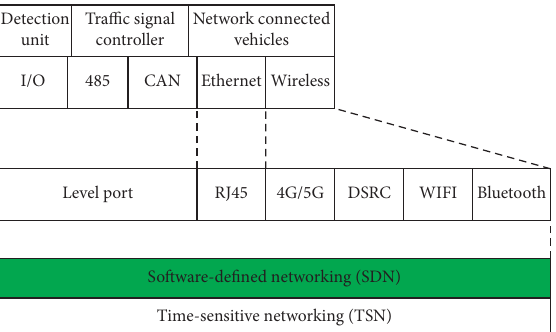
Figure 10: Structure of intelligent